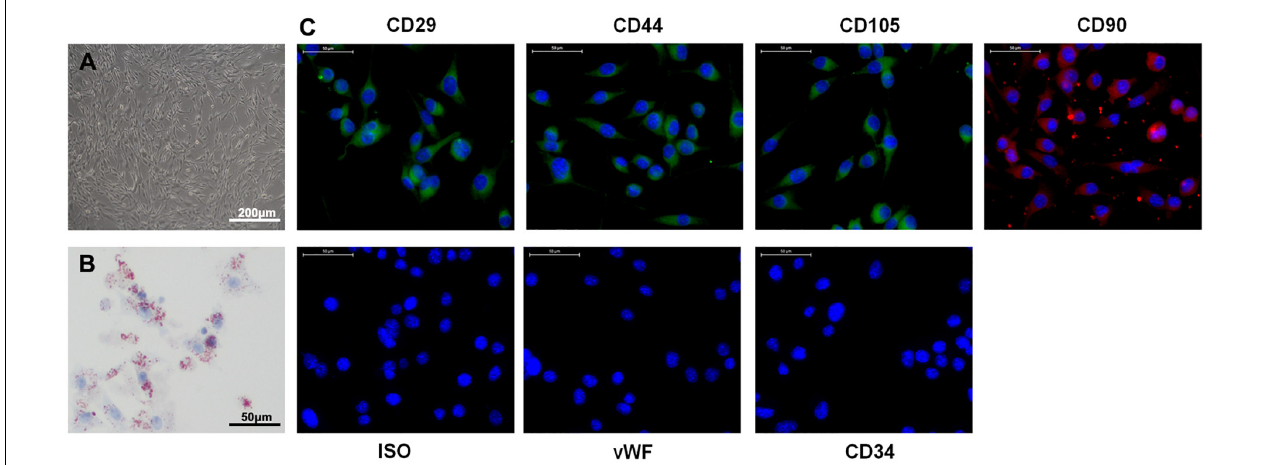
FIGURE 1 | Characteristics of ADSCs. (A) Typical fibroblastic-like morphology of ADSCs. (B) Adipogenesis was detected on day 18 using Oil Red O staining. (C) Assessment of cell surface markers by immunofluorescence staining. ADSCs were positive for MSC markers CD29, CD44, CD90, and CD105, but negative for endothelial markers CD34 and vWF. Negative isotype controls are shown. Nuclei were counterstained with DAPI (blue). Scale bars = 50 mm.